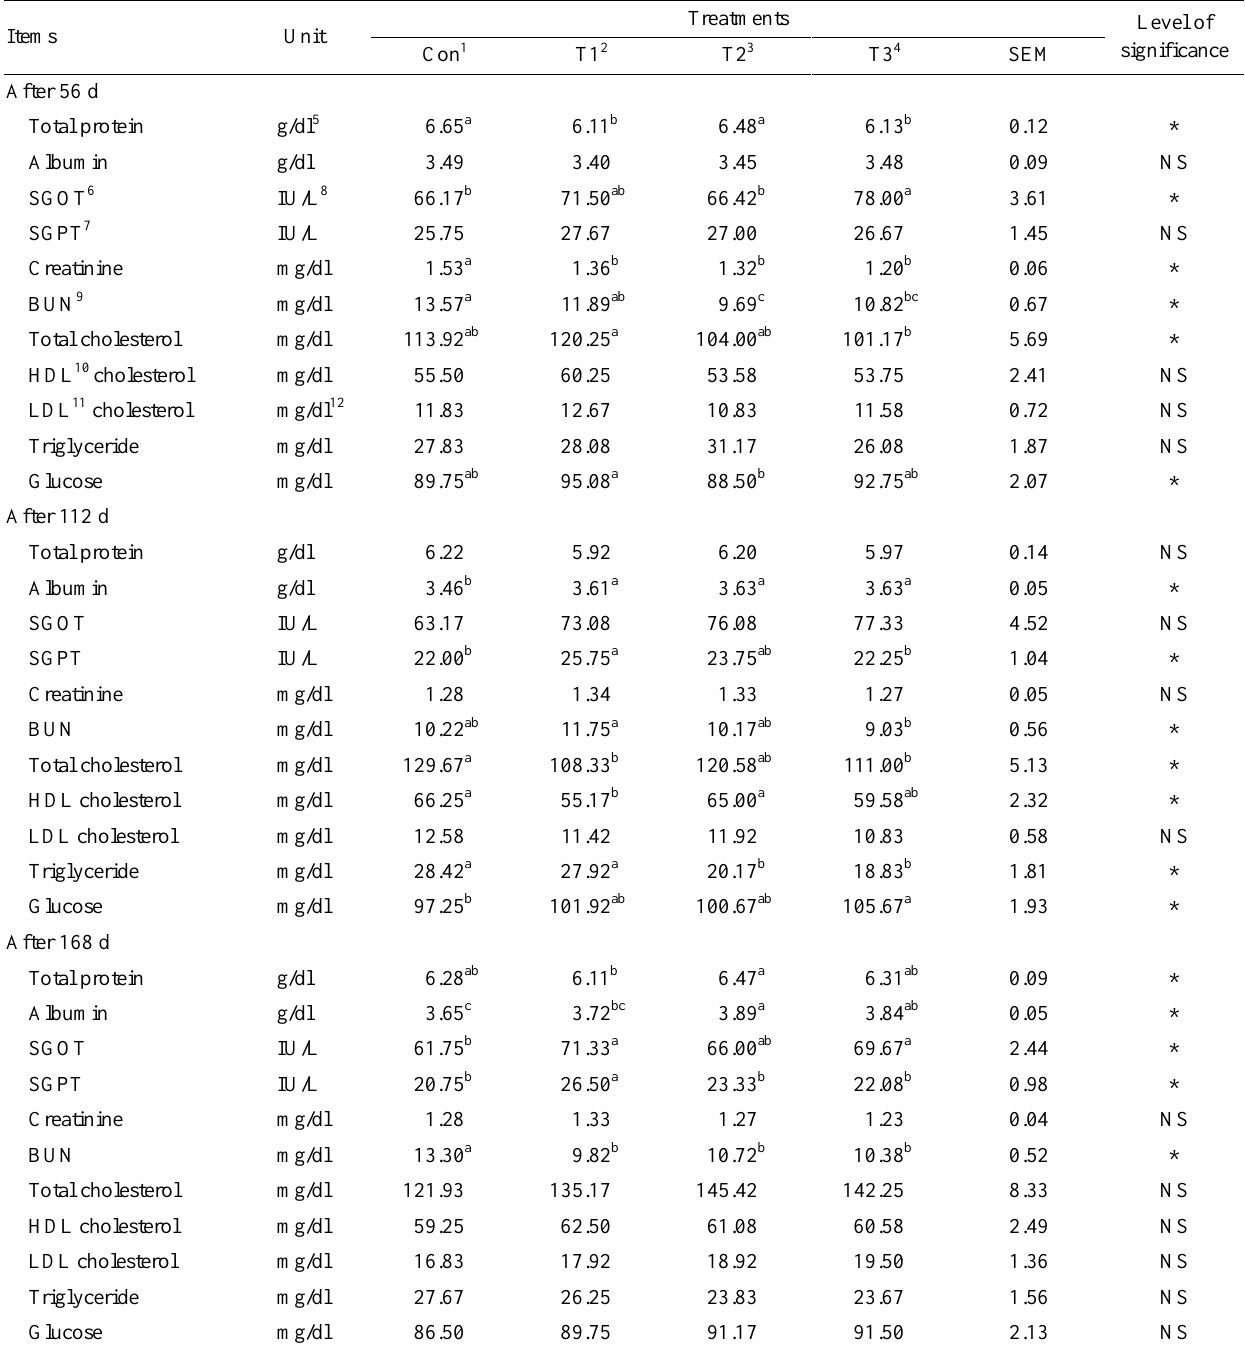
Treatments Level of